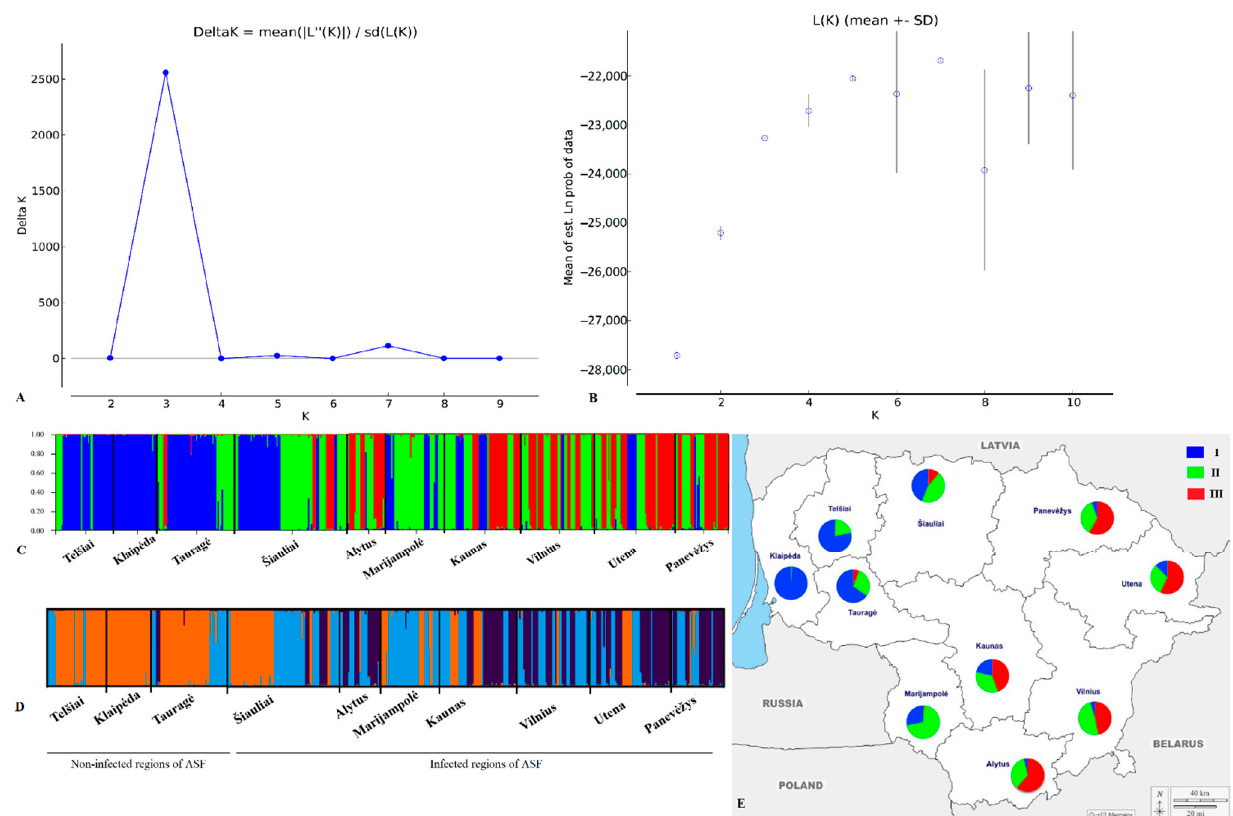
Figure 4. ( A ) Magnitude of delta K ( ∆ K) statistics for the S. scrofa collection based on 13 microsatellite loci. ( B ) STRUCTURE results: mean ( ± SD) of estimated Ln probability of the data for each K value. ( C ) Population structure of S. scrofa individuals collected from the sampling sites, estimated according to the Bayesian model by STRUCTURE program version 2.3.4 (K = 1–10). ( D ) Output from CLUMPAK, visualising major modes for K = 3 from the individual-based clustering performed in STRUCTURE. Each vertical line represents a single individual, and the colour shows the proportion of each individual assigned to each of the three genetic clusters. ( E ) Map showing the distribution of genetic groups determined by STRUCTURE analyses. Pie charts represent the proportions of each cluster.